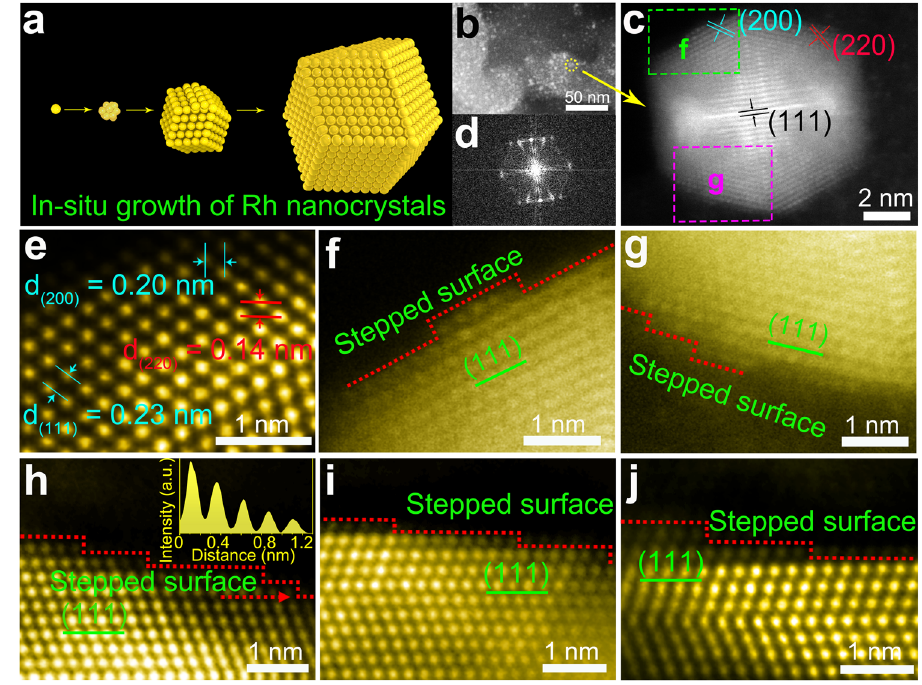
Fig. 2 | Atomic scale HAADF-STEM characterization of Rh/GDY. a Simulated atomic arranging process and model of individual Rh nanocrystal. b HAADF-STEM imageof Rh/GDY. c High-resolutionHAADF-STEMimageofasingleRhnanocrystal grown on GDY. The labelled squares indicate the areas magni fi ed in the following observations. d Fast Fourier transform pattern of Rh/GDY from c . e HAADF-STEM